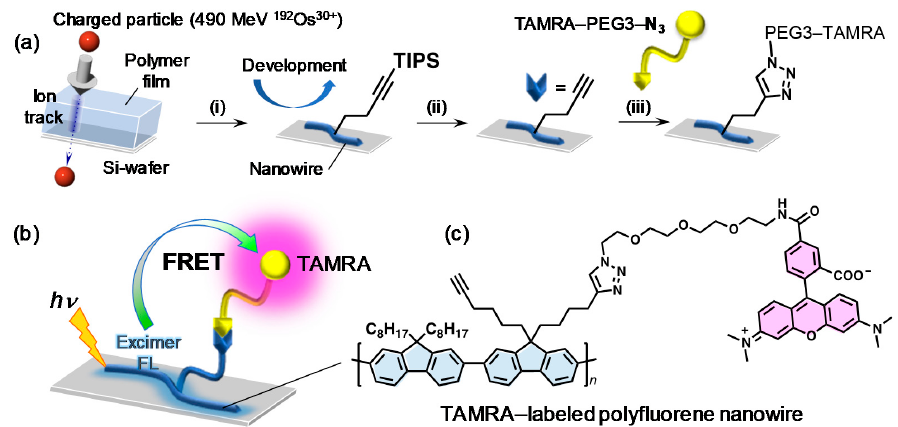
Figure 6. ( a ) Schematic illustrations of 5(6)-Carboxytetramethylrhodamine(TAMRA)-labeled polyfluorene nanowire fabrication by the SPNT: (i) High-energy charged particles induce nonhomogeneous cross-linking reactions along the “single” particle trajectories in a polymer